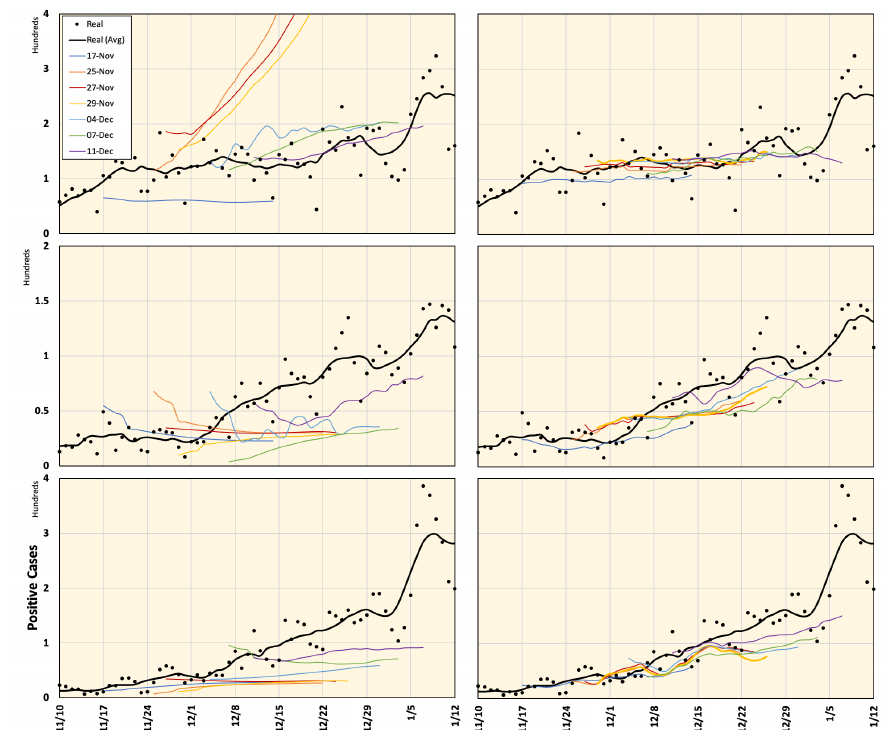
Figure 7. Prediction of COVID-19 positive cases in Hyogo, Kyoto, and Fukuoka (from top to bottom) released by Google Cloud ( left ) and computed using the proposed framework ( right ), compared to the actual real data for different time frames defined in Figure 5. All plots represent a 7-day average